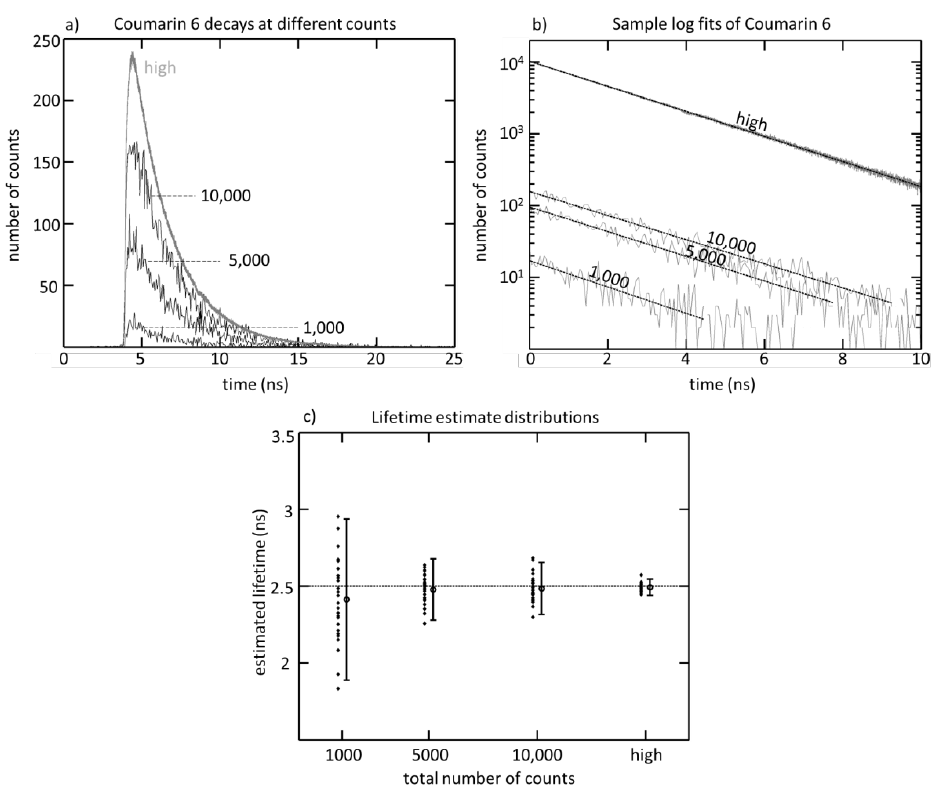
Figure 3. Fluorescence lifetime estimation of Coumarin 6. ( a ) TCSPC histograms for a SPAD after a range of different numbers of photon counts. The decay resulting from a “high” (>20,000,000) number of counts is scaled independently of the other three cases, and so does not correspond with the left axis; ( b ) logarithmic fits of TCSPC histograms under different count scenarios; and ( c ) results for lifetime estimation under each count scenario, as an ensemble of all SPADs in the array, with 95% confidence interval